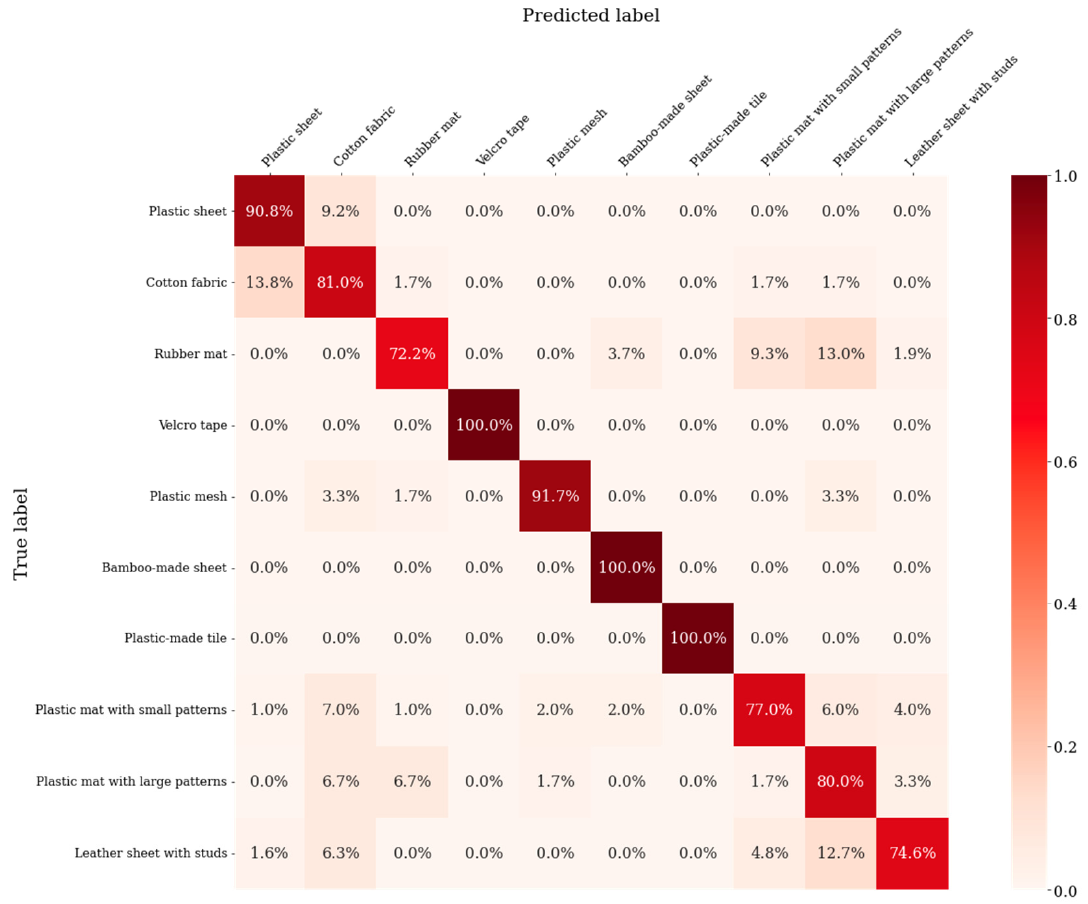
Figure 12. Confusion matrix of classification for ten different materials at sliding speed 10 cm/sec.